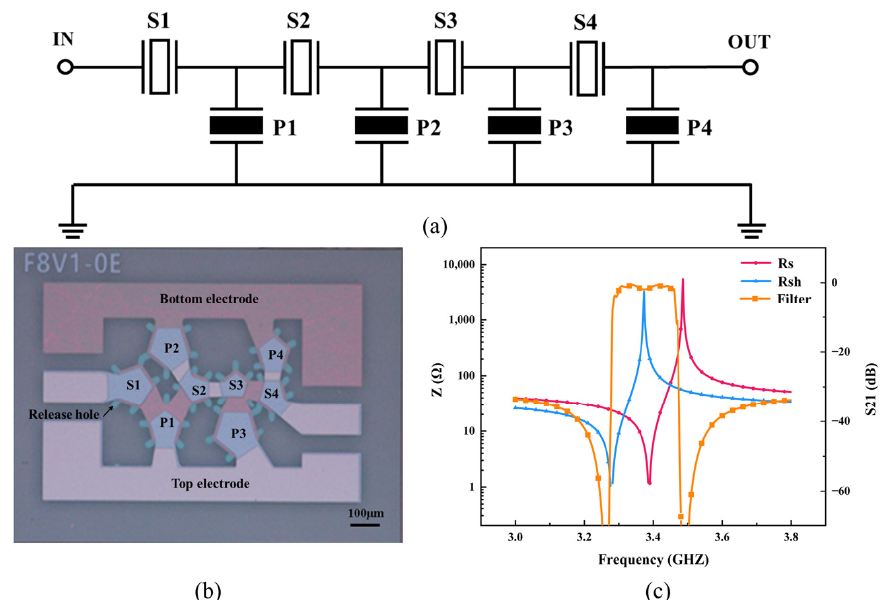
Figure 7. Single crystal AlN BAW filter, ( a ) structure of BAW filter, ( b ) fabricated single crystal BAW filter, and ( c ) simulated results of the series resonator, shunt resonator, and filter. Table 1. Simulated and measured resonant frequency of resonator. Shunt